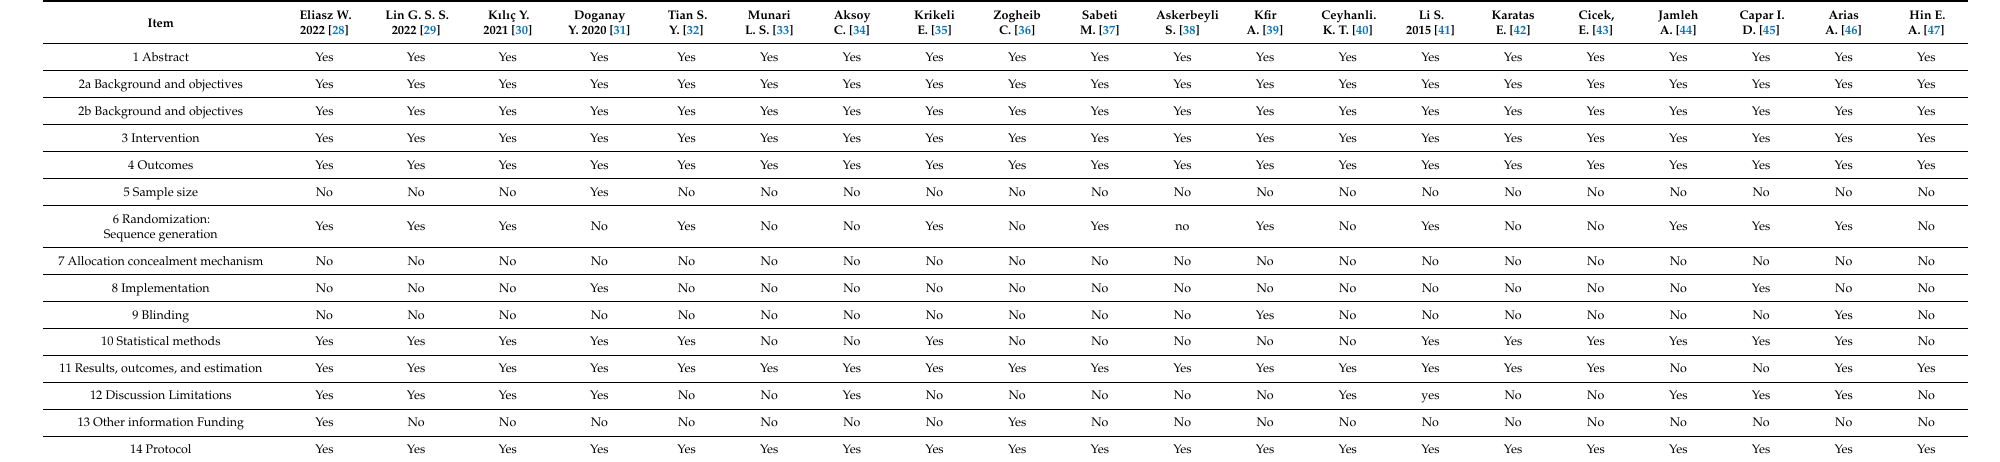
Table 2. Summary of the bias risk for in vitro studies, according to